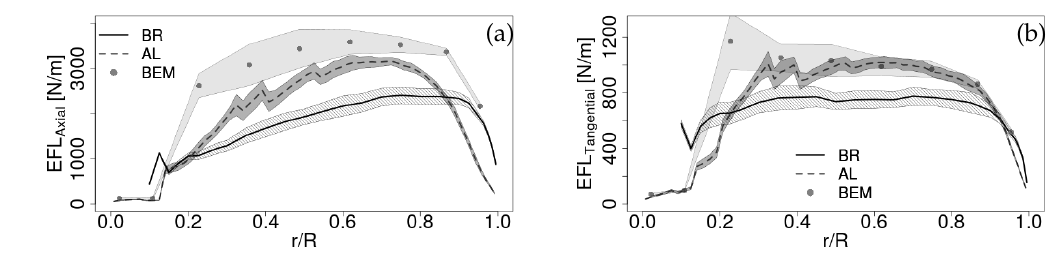
Figure 10. Radial distribution of ( a ) axial and ( b ) tangential equivalent fatigue loads per unit span. The shaded areas correspond to the errors.